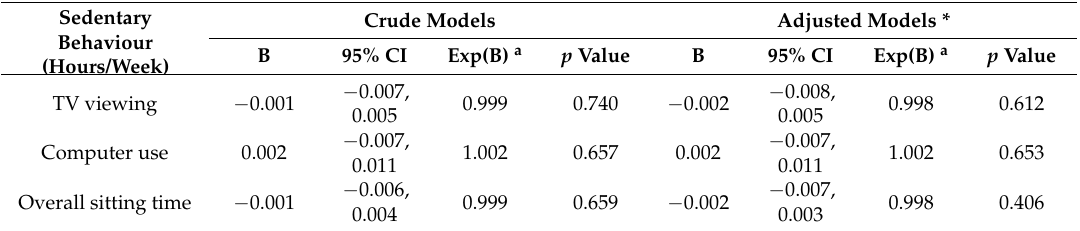
Table 2. Linear regression analyses examining associations between sedentary behaviour and hair cortisol level